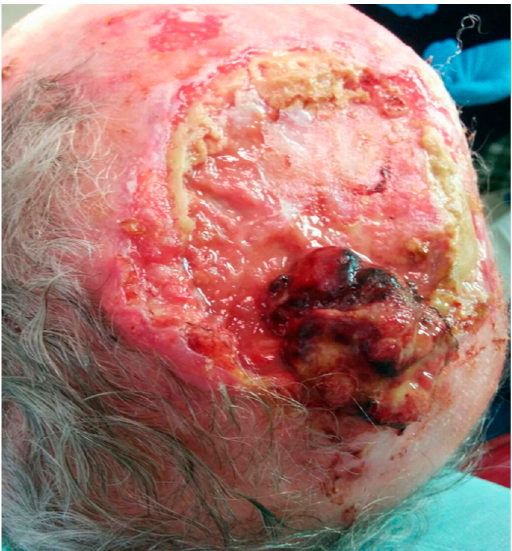
Figure 7. ALT flap. Squamous cell carcinoma of the parietal and temporal region.